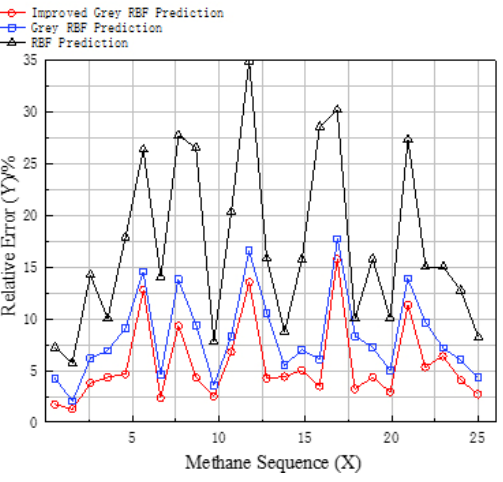
Figure 9. Relative errors of three models.